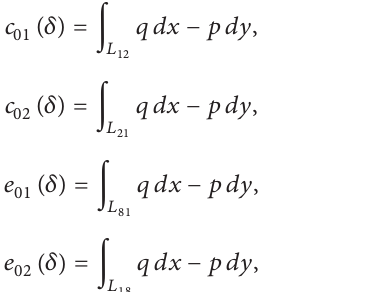
(𝑥 , 𝑦 ) inside the 2- 𝑖 𝑖 𝑖